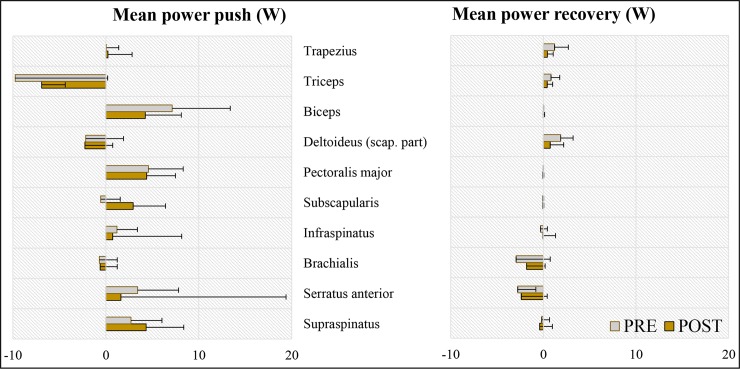
DSEM estimates of individual muscle powers (N  =  7; median and IQR) during the push (left) and recovery (right) phase for the pre- and the post-test. Only the muscles that had mean muscle forces during the push phase larger than 25 N are illustrated. The muscles are arranged in a descending order based on their physiological cross-sectional area.